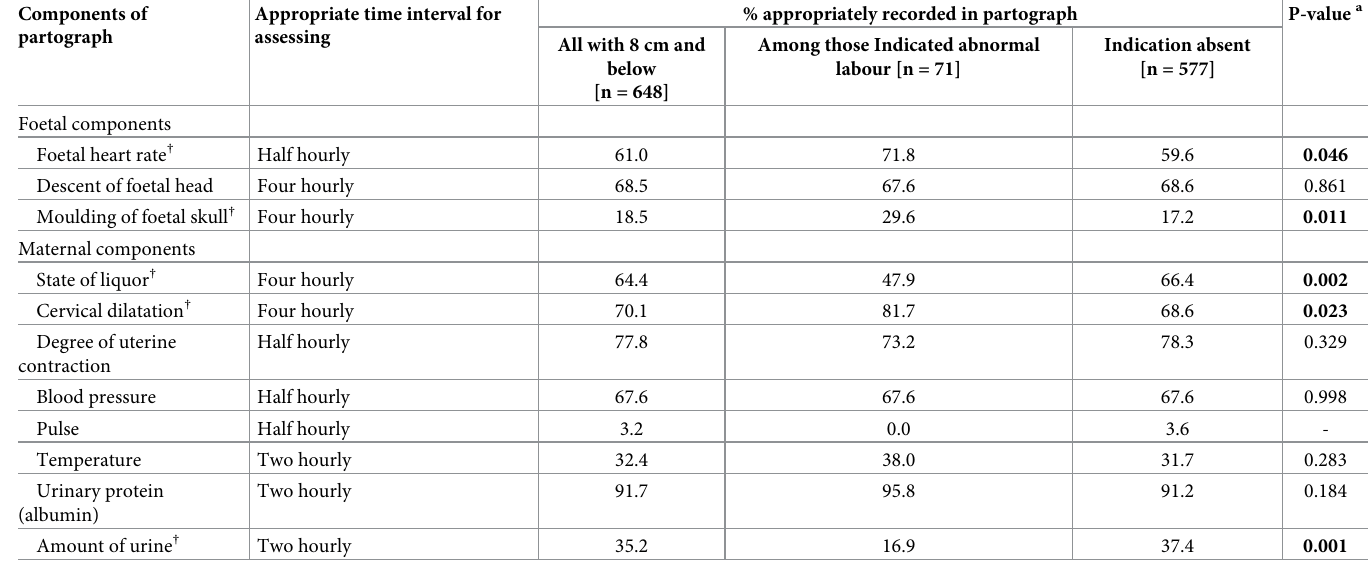
Table 5. Appropriate recording of partograph components for all women admitted for childbirth at the study health facilities. Components of